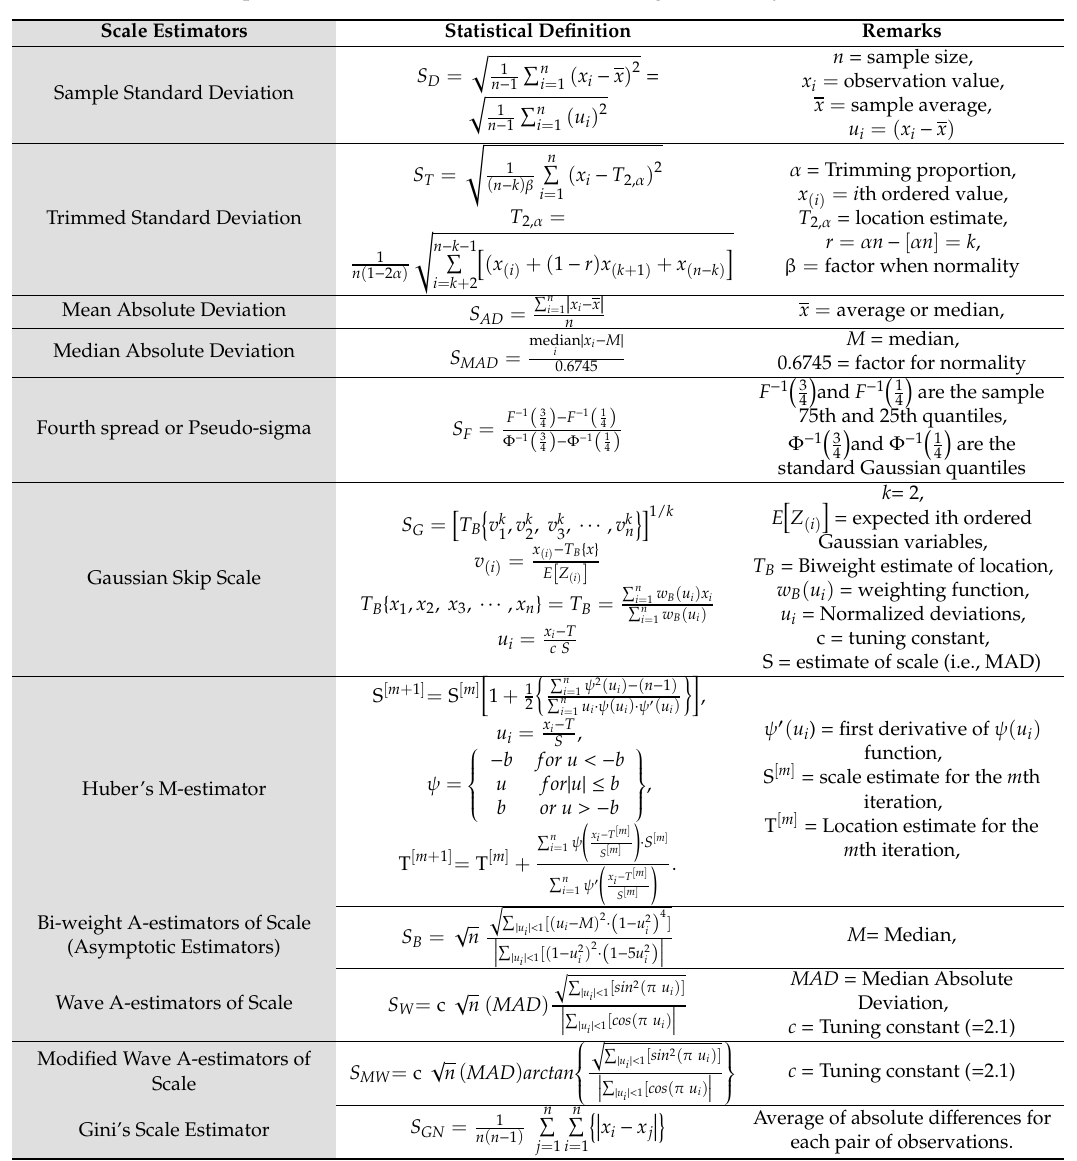
Table 1. Some examples for estimates of scale when describing uncertainty for a set of